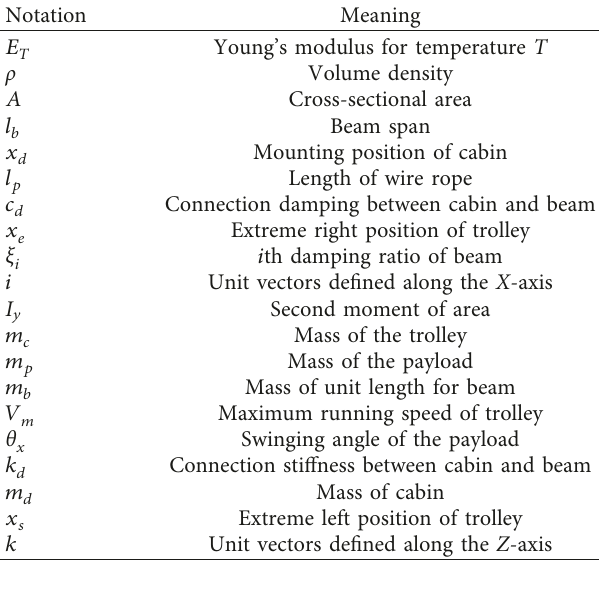
Table 3: Notation and meanings of